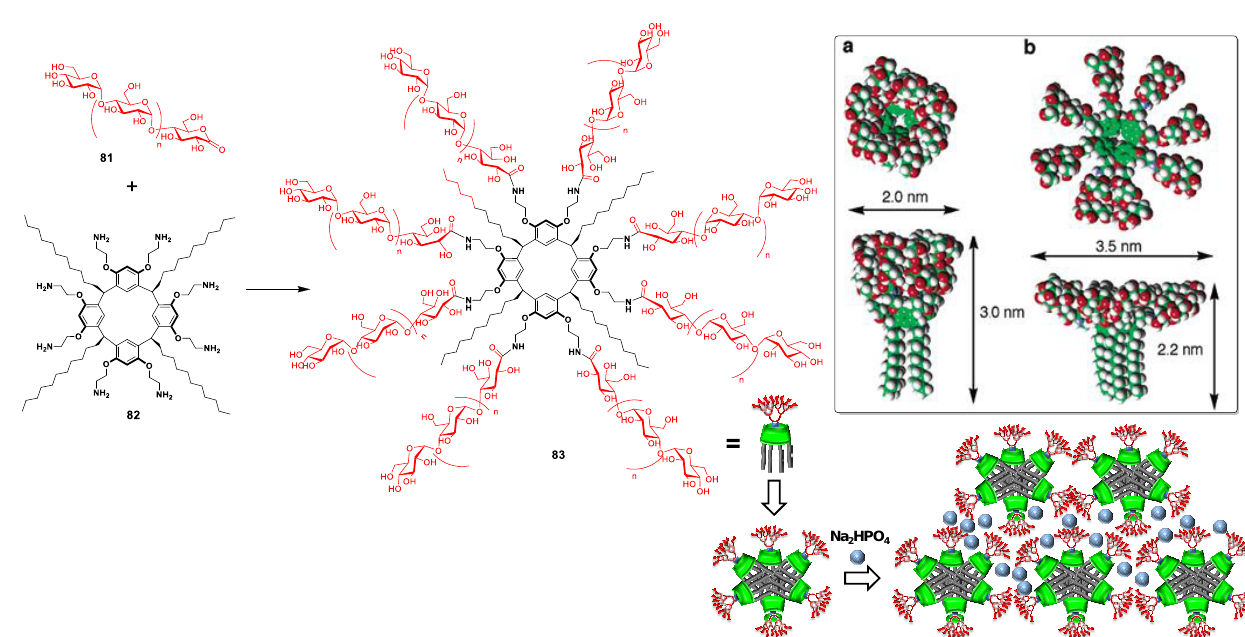
(Adapted from ACS